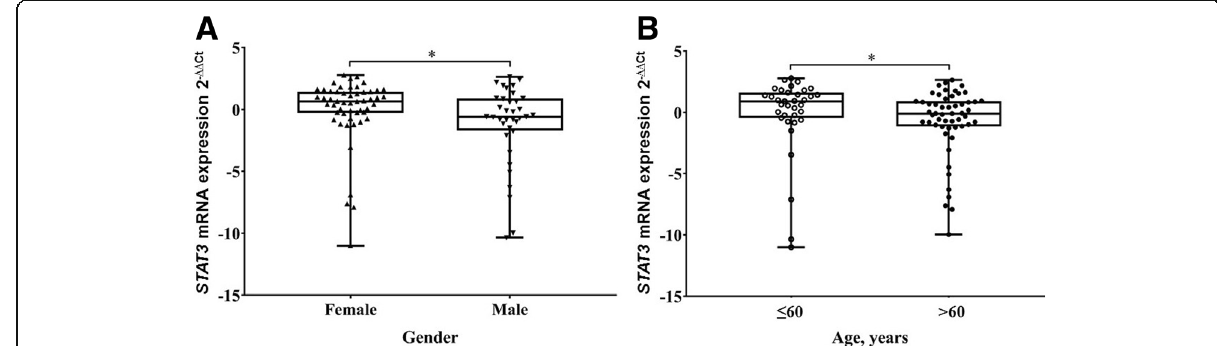
Fig. 3 STAT3 mRNA expression associations with patient characteristics. a Box plots of STAT3 mRNA expression association with gender. b Box plots of STAT3 mRNA expression association with patient age. The line inside box represents the median, the lower and upper edges of the boxes represent the 25th and 75th percentiles, respectively, and upper and lower lines outside the boxes represent minimum and maximum values (error bars). The Mann-Whitney test showed, that males and patient group older than 60 years were significantly associated with reduced STAT3 mRNA expression ( p < 0.05)